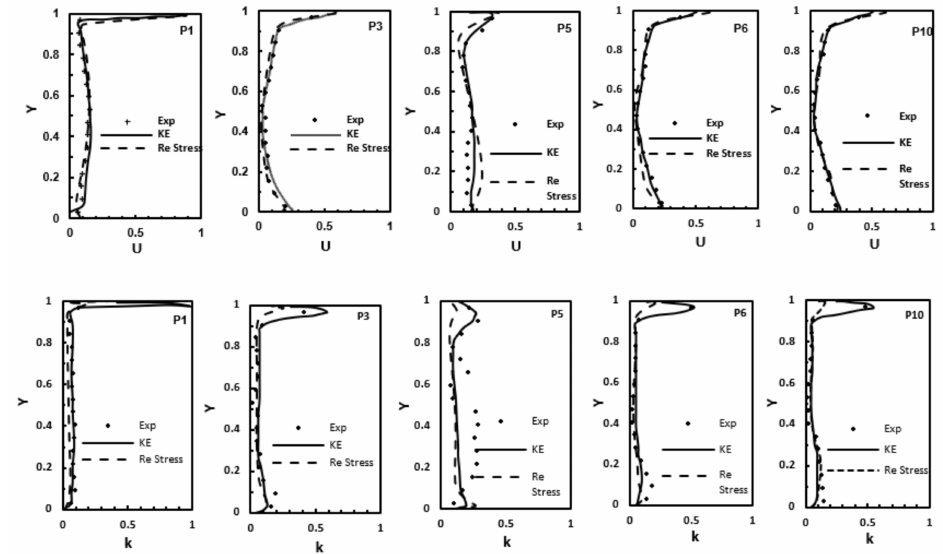
Figure 2. Comparison of normalized velocity and turbulence kinetic energy profiles at monitoring points 1, 3, 5, 6 and 10 for case 1, predicted by the RNG k- ε and the Reynolds Stress turbulence models,